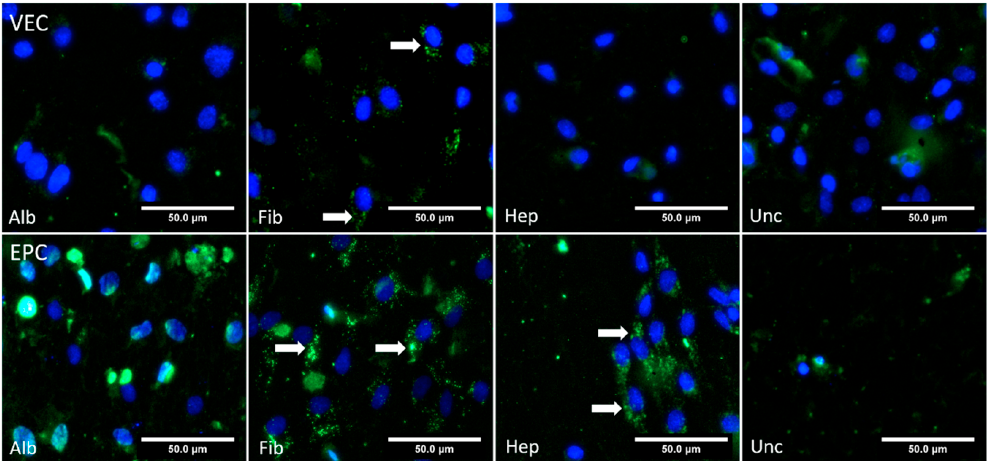
Figure 10. Fluorescence microscopy images from vascular endothelial cells (VEC) and endothelial progenitor cells (EPC) cultured under dynamic conditions on bacterial nanocellulose grafts coated with albumin (Alb), fibronectin (Fib), heparin–chitosan (Hep) and on uncoated (Unc) grafts. The cell nuclei were stained against DAPI (blue), and acetylated low density lipoprotein particles are shown in green (indicated by arrows).